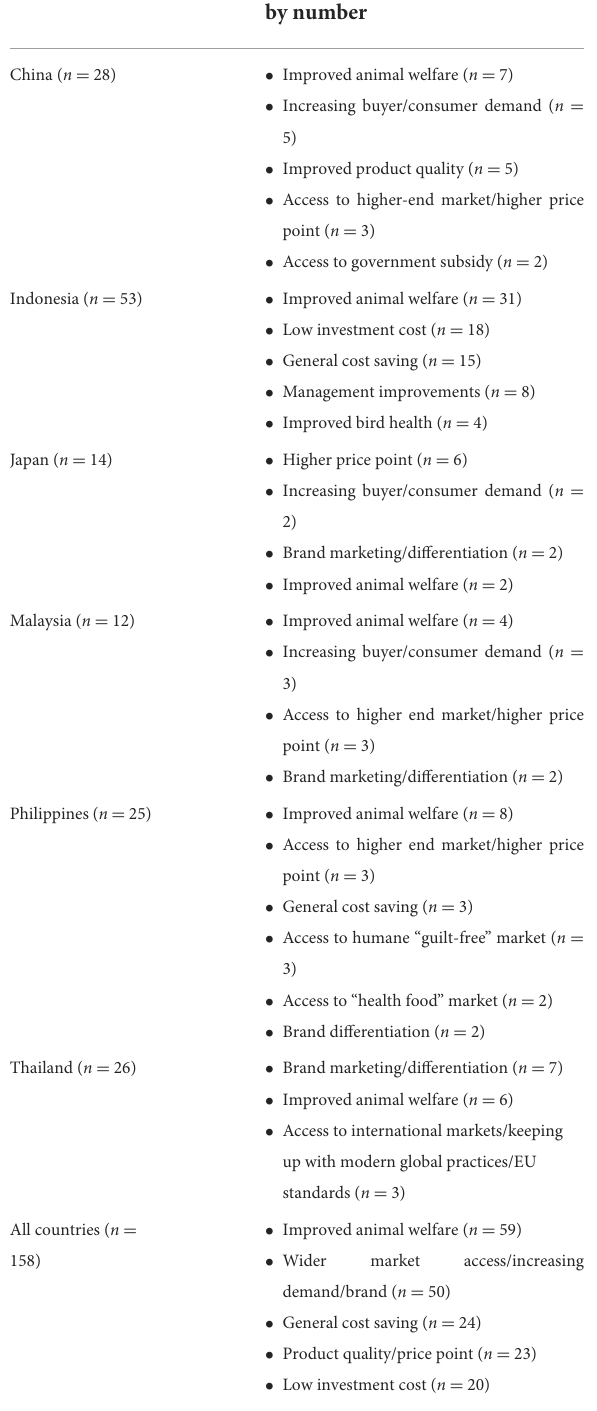
TABLE 3 Ranking of perceived reasons that cage-egg producers adopt cage-free systems in each country, including frequency of appearance of response ( n ) per